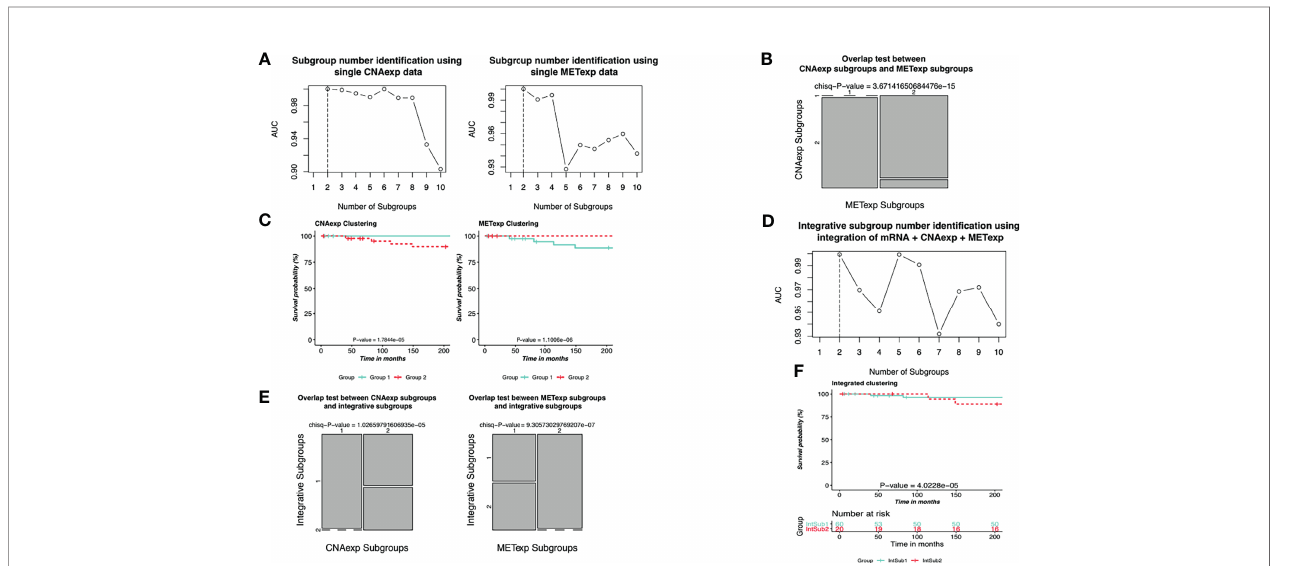
FIGURE 3 | Identi fi cation of UM molecular subgroups using individual CNAexp and METexp genes for single clustering and mRNA + CNAexp + METexp for joint clustering. (A, D) AUC values obtained for each value of k . The optimal k has the highest AUC value, in which ( A — left, A – right, and D ) the results are of CNAexp alone, METexp alone, and integration of mRNA + CNAexp + METexp, respectively. (B) Overlap test between subgroups of CNAexp and METexp. (E) Overlap test between integrative subgroups versus CNAexp subgroups (left) and versus METexp subgroups (right). (C, F) Kaplan – Meier survival curves for the CNAexp subgroups ( C — left), METexp subgroups ( C — right), and (F) integrated